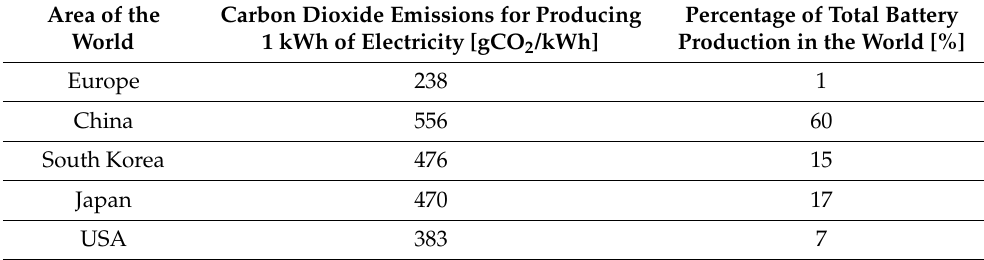
Table 2. Carbon dioxide emissions for producing 1 kWh of electricity and percentage of battery production in the world. Area of the Carbon Dioxide Emissions for World